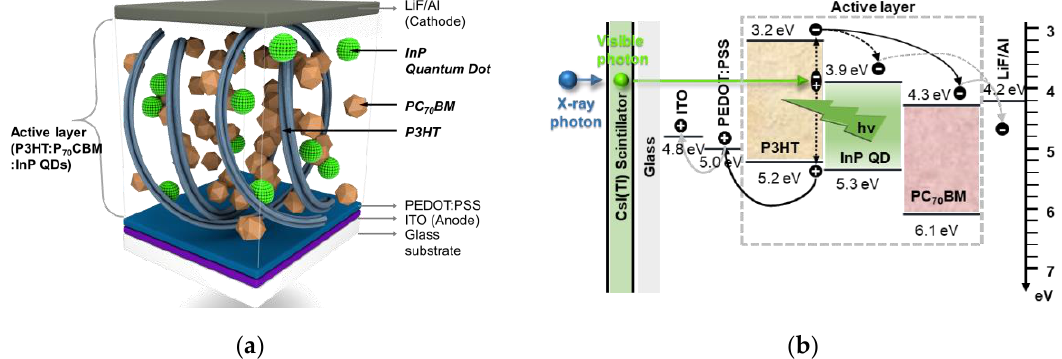
Figure 1. ( a ) The heterojunction structure of detector with P3HT:PC 70 BM:InP quantum dots (QDs) image and ( b ) schematics diagram with corresponding energy band diagram.